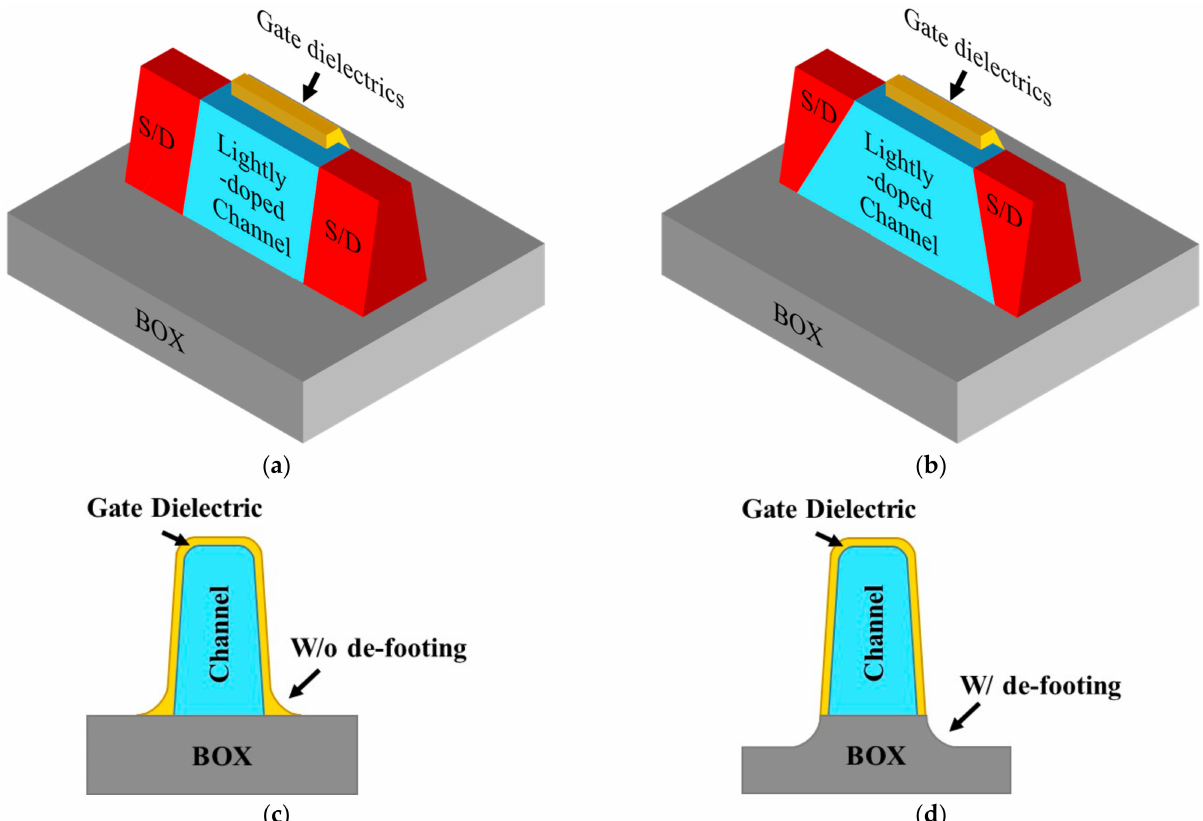
Figure 1. Comparison between a conventional SOI FinFET and the proposed 3D design. ( a ) A 3D schematic of a conventional SOI FinFET with a vertically uniform S/D, ( b ) a 3D schematic of the SOI FinFET with the proposed 3D S/D design, ( c ) the fin cross-section in a conventional SOI FinFET and ( d ) the fin cross-section in with an optimized gate